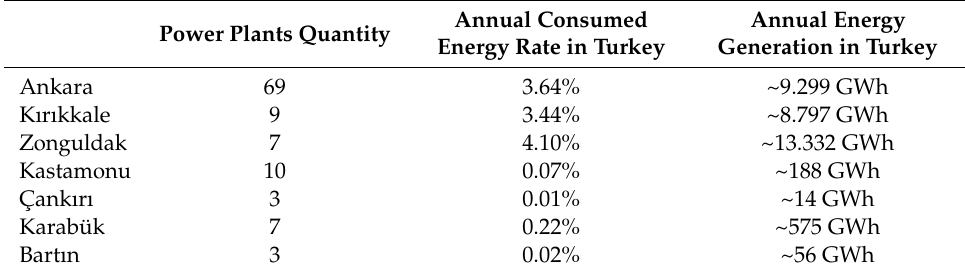
Table 1. Some energy consume and generate details of province which are under the control of ankara province